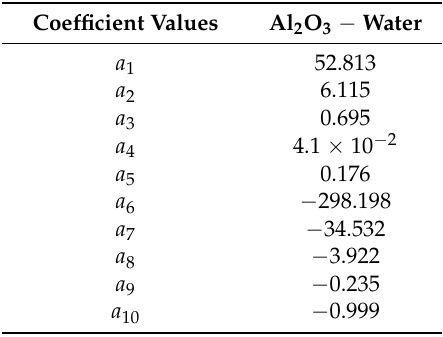
Table 2. Properties of water and Al 2 O 3